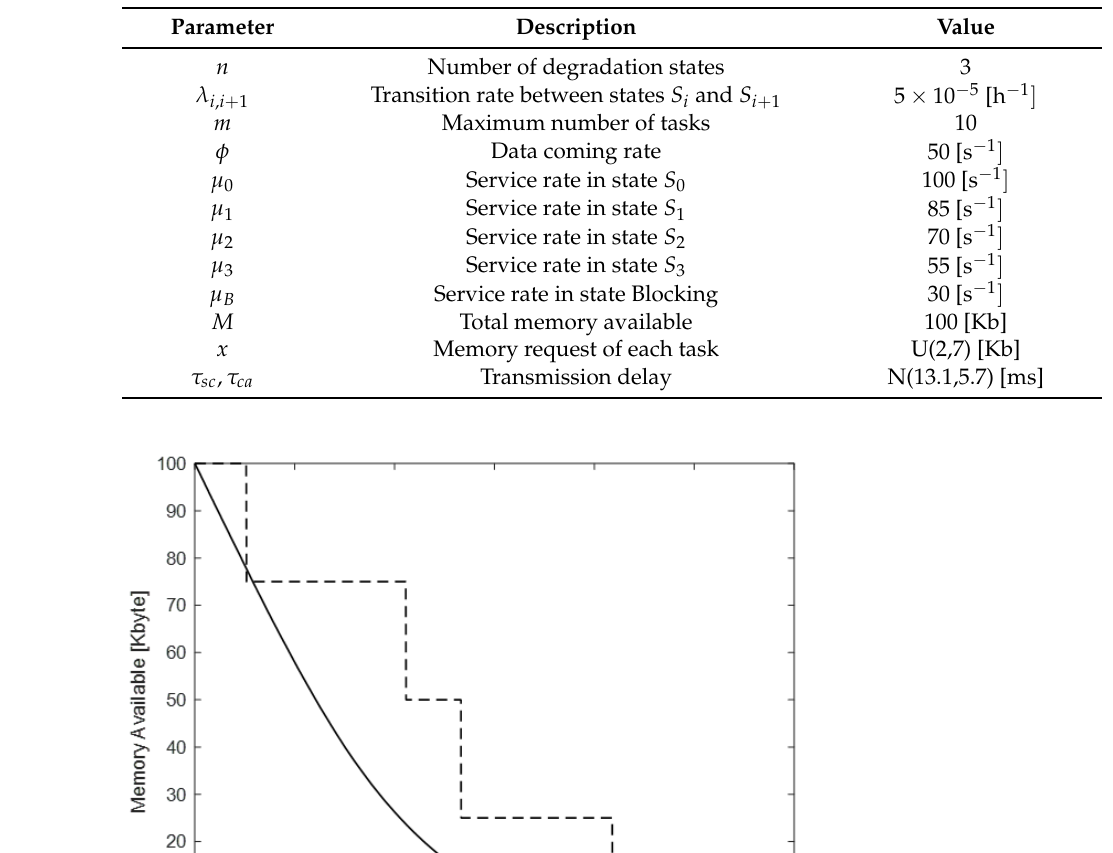
Table 2. Parameters for cyber aging model.